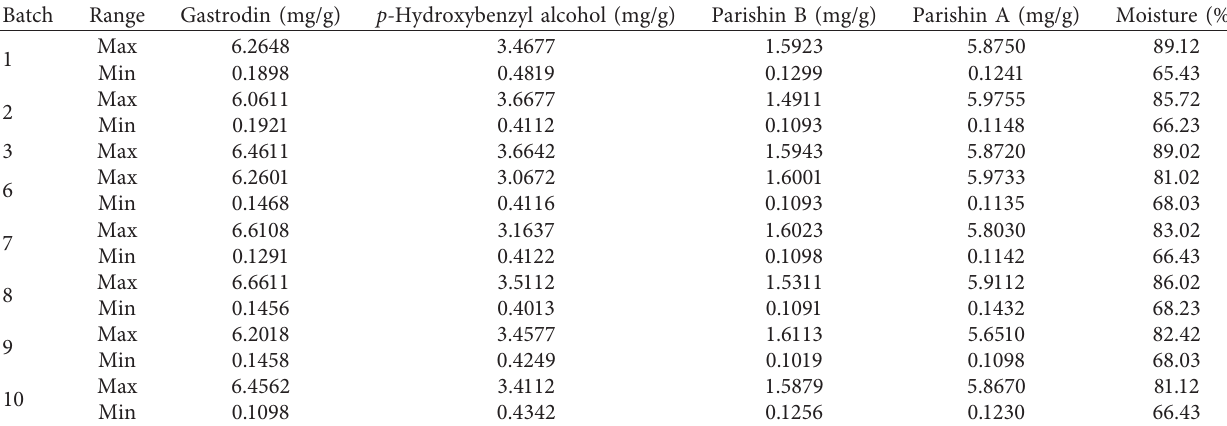
Table 2: Results of four analytes and moisture contents of 200 samples.